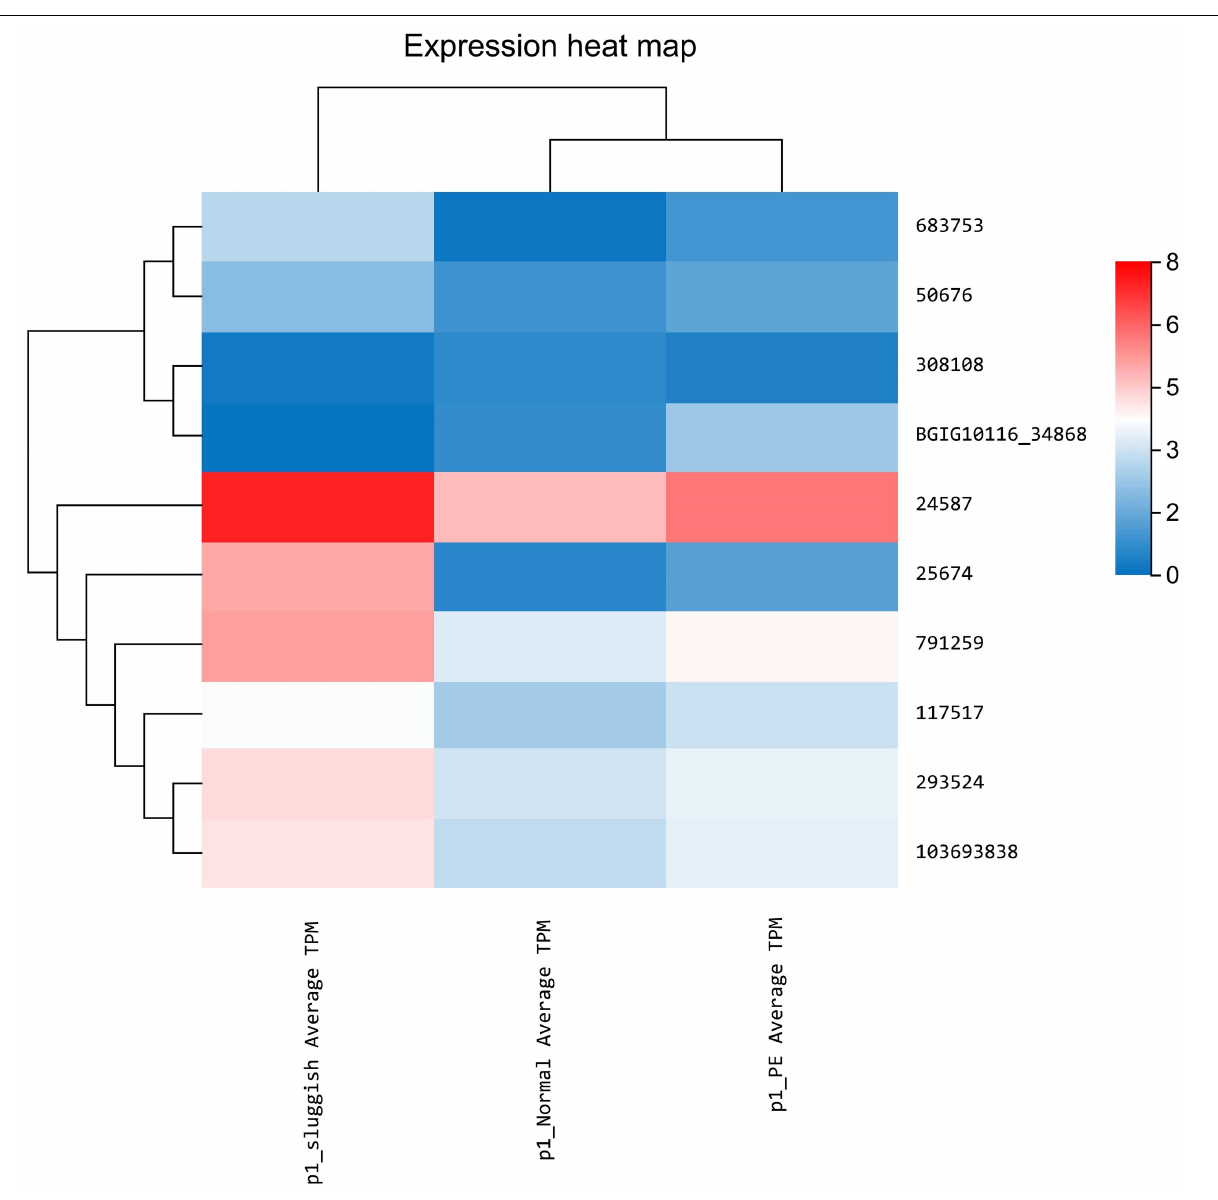
FIGURE 2 | Expression of different genes in premature ejaculation